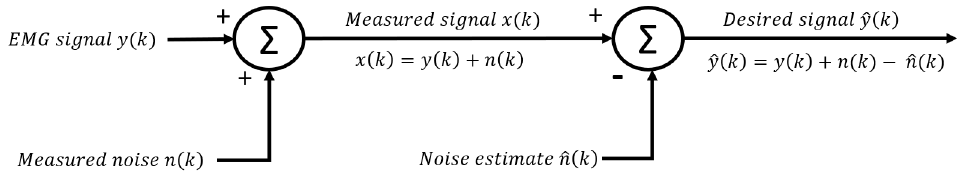
Figure 3. Principle of the subtraction methods in the time